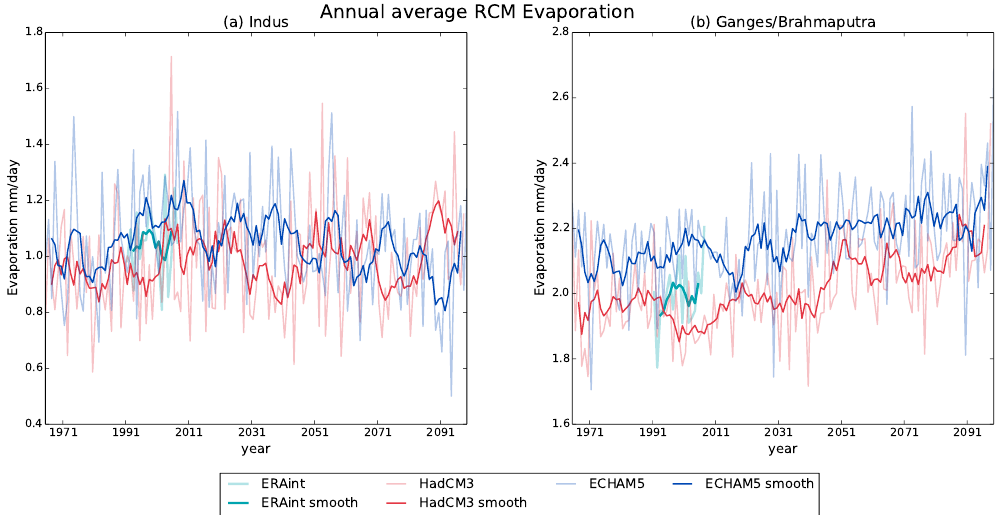
Figure 7. Annual mean evaporation for the Indus (a) and Ganges–Brahmaputra (b) catchments for each model run (HadCM3 – red, ECHAM5 – blue, ERAint – cyan lines) from 1971 to 2100. Paler lines are annual averages and darker lines are a 5-year rolling smoothed